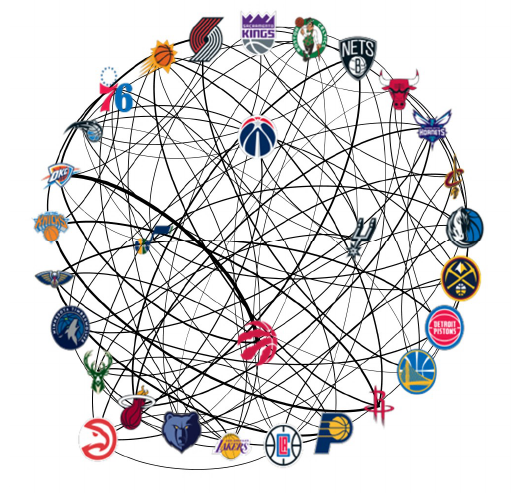
Figure 1. The graph for the first three days’ games of the 2018–2019 NBA